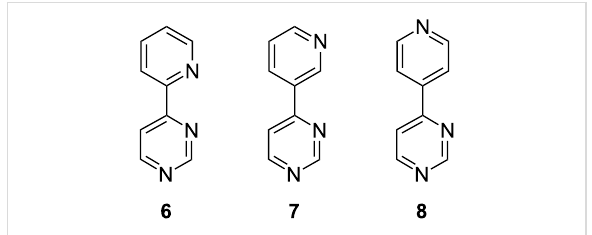
Figure 2: Starting 4-pyridylpyrimidines 6 – 8